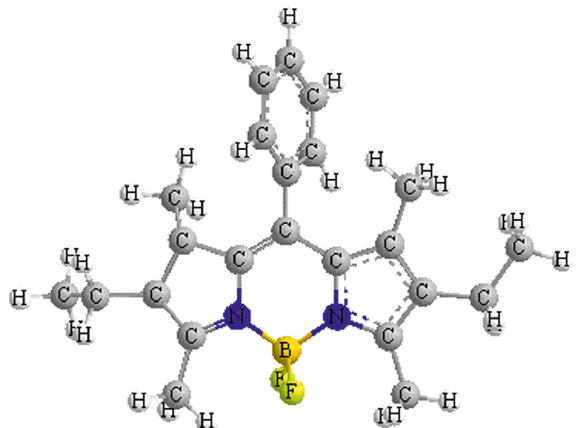
Figure 1: The chemical structure of 2,8-diethyl-1,3,5,7-tetramethyl-9-phenylbipyrromethene difluoroborate (BODIPY-520).